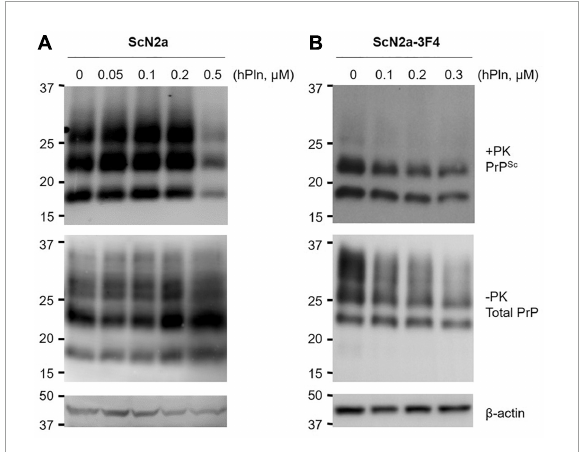
FIGURE3 Plasmin reduces PrP Sc formation in cultured cells. ScN2a cells were grown in the presence of increasing concentrations of hPln. (A) The levels of total endogenous PrP ( − PK) and PrP Sc (+ PK) accumulation in ScN2a cells cultured under the 10% FBS condition were evaluated by western blotting using anti-PrP antibody D13. (B) De novo formation of PrP Sc during hPln treatment was determined in ScN2a cells transiently transfected for PrP C -3F4 expression (ScN2a-3F4), which were cultured under the 2% FBS condition. PrP-3F4 (-PK) and PrP Sc -3F4 (+ PK) were specifically detected in western blots probed with anti-PrP antibody 3F4. β -actin was used as a reference protein to ensure equal amounts of each cell lysate were